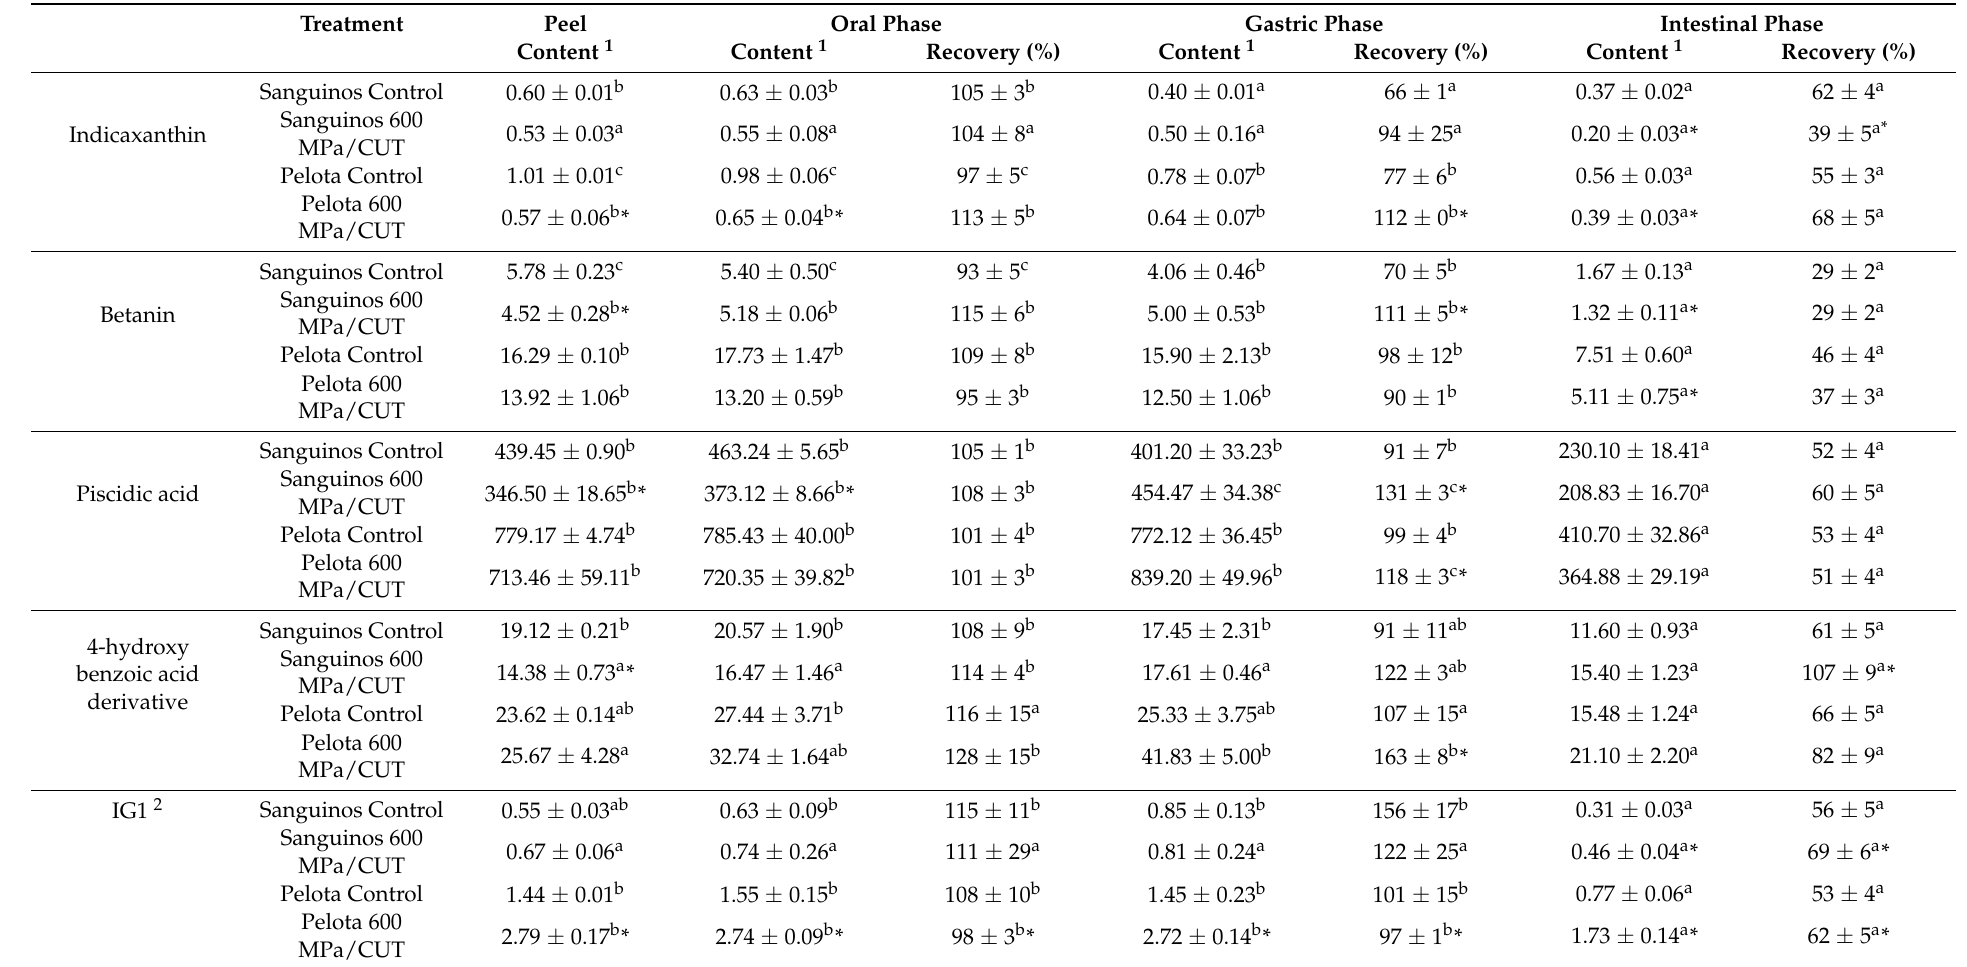
Table 5. In vitro digestive stability (mg/100 g fresh weight) of betalains and phenolic compounds in HHP-treated (600 MPa/CUT) Sanguinos and Pelota prickly pear